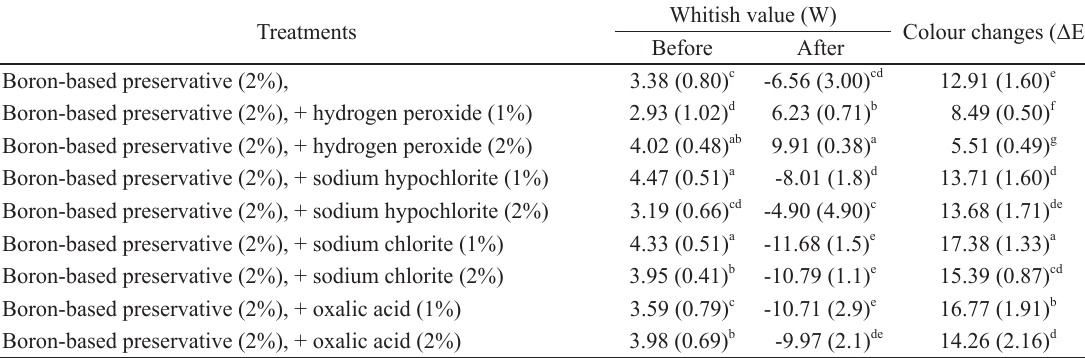
Mean (+ Sd) of 10 replicates for each species. values followed by the same letter are not significantly different in the same group at the 0.05 level of